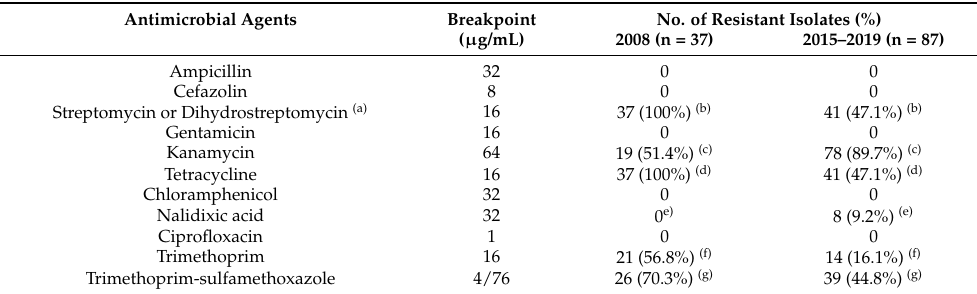
Table 1. Antimicrobial resistance of Salmonella enterica serovar Schwarzengrund isolates from chicken meat in